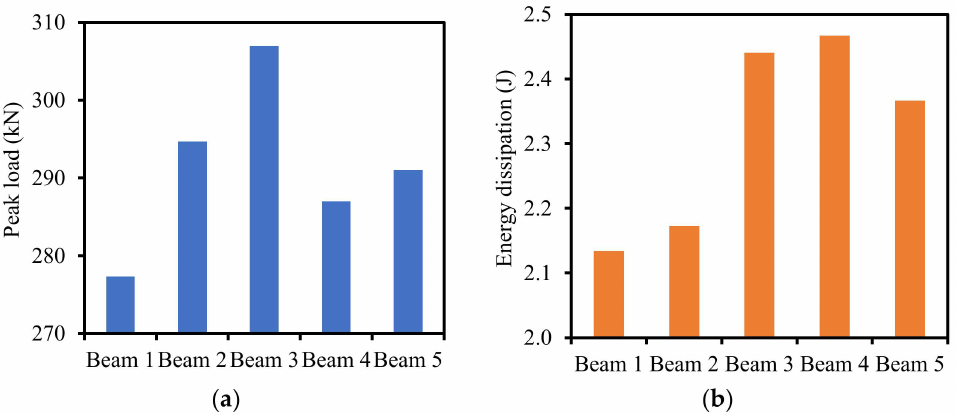
Figure 13. The comparison of the flexural behaviors of the investigated beams: ( a ) peak load, and ( b ) energy